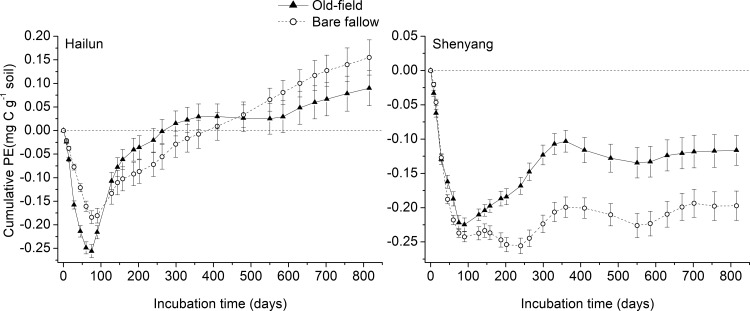
Cumulative PE (priming effects, mg C g-1 soil) of added maize on SOC decomposition of old-field (triangle and solid line) and bare fallow (circle and dotted line) soils from Hailun (left) and Shenyang (right) station during 815 days incubation.Error bars show ±1 SE.